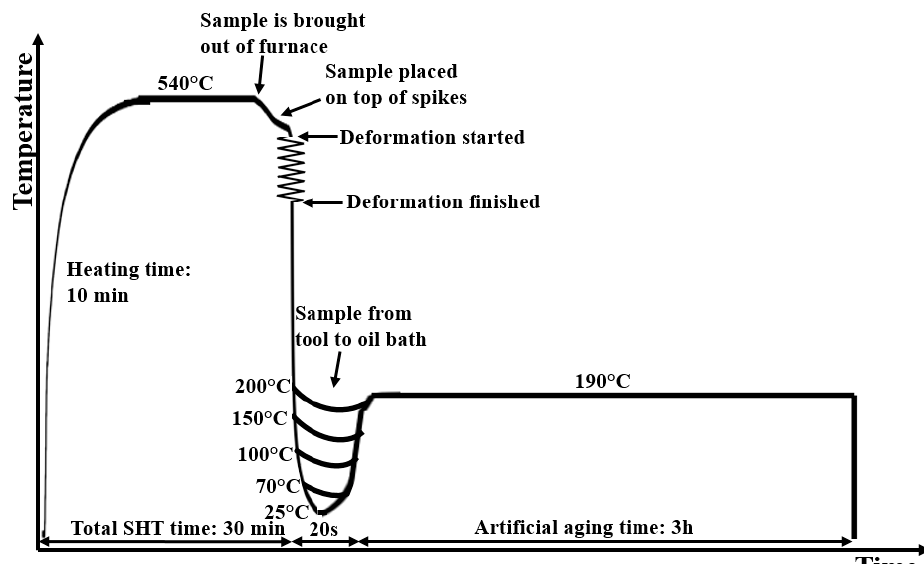
Figure 2. Illustration of the integrated hot forming and in-die quenching (HFQ) heat treatment sequence for samples being directly artificially aged.